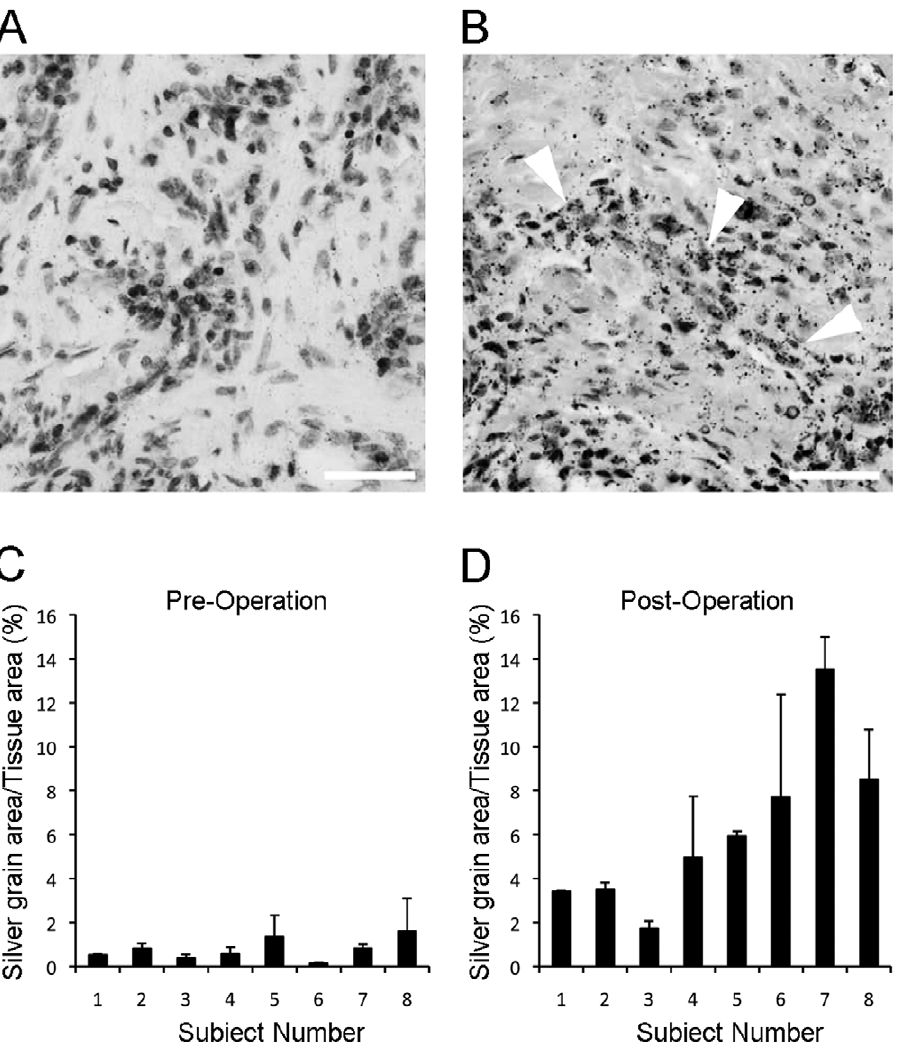
Figure 1. Expression of FGFR1OP2/wit3.0 in post-tooth extraction oral mucosa. A . In situ hybridization of FGFR1OP2/wit3.0 probe showed negative in human oral mucosa tissue prior to implant placement. Bar=50 m m B . Oral mucosa tissue was harvested from the same subject when the implant was uncovered. The healed mucosa expressed positive hybridization of FGFR1OP2/wit3.0 probe in a cluster of fibroblasts (arrowheads). Bar=50 m m C . In situ hybridization experiments in pre-operative oral mucosal tissue depicted constitutive FGFR1OP2/wit3.0 expression. D . The post- operative oral mucosal showed the increased expression of FGFR1OP2/wit3.0 in all subjects, albeit with significant variations.